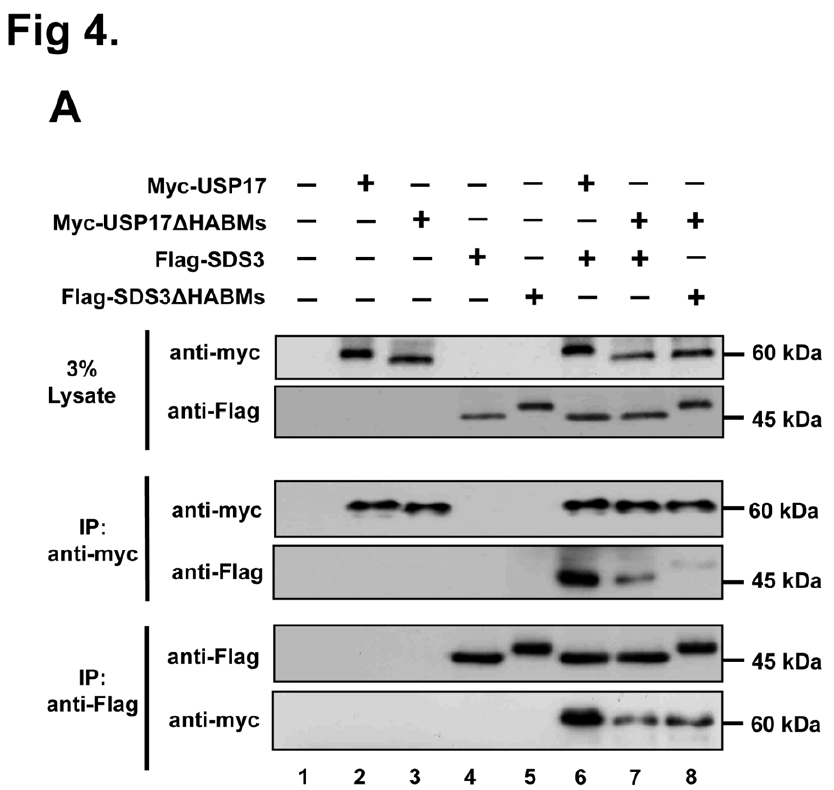
Figure 4. HABMs deleted USP17 deubiquitinates SDS3. A ) Interaction between HABMs deleted USP17 and SDS3. B ) Interaction between USP17 D HABM1 or USP17 D HABM2 and SDS3. Interaction was confirmed by co-immunoprecipitation with either an anti-myc antibody or an anti-Flag antibody. C ) Deubiquitination of SDS3 by HABMs deleted USP17. 293 T cells were transfected with the respective expression constructs. A deubiquitinating assay was performed by co-immunoprecipitation with an anti-Flag antibody and immunoblotting using an anti-HA